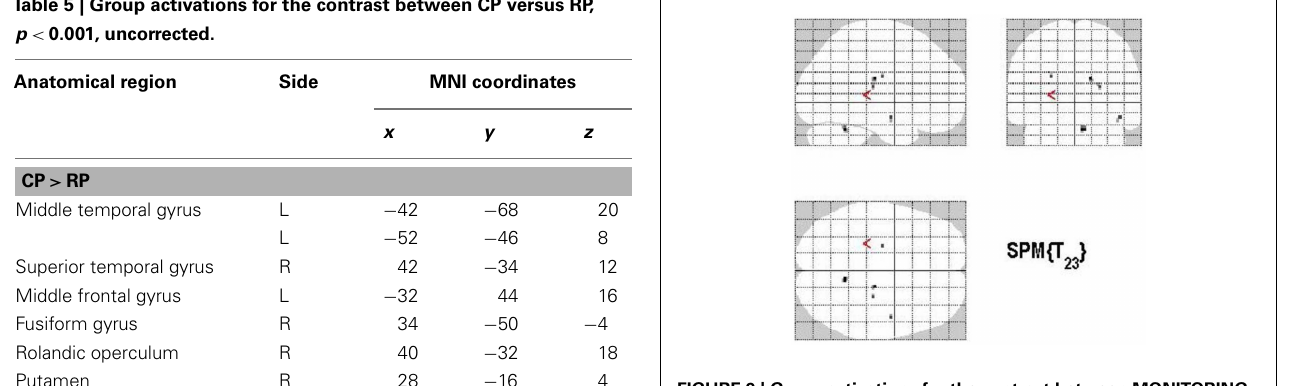
FIGURE 9 | Group activations for the contrast between MONITORING versus CONTROL. Activations are superimposed on the anatomical group mean image (see Materials and Methods), depicting statistically significant relative increases in neural activity at p < 0.001, uncorrected. See Table 6 for the exact MNI coordinates.